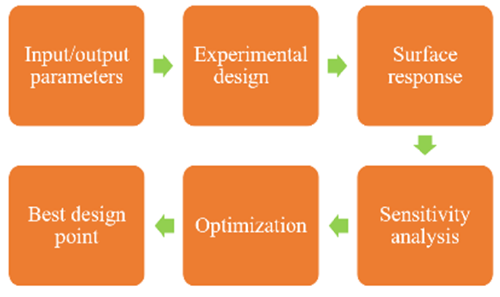
Figure 2. Optimization process.